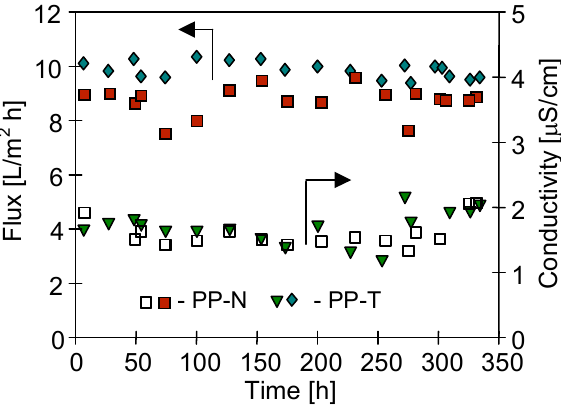
Figure 6. The changes of permeate flux and distillate conductivity during MD process. T F = 353 K.